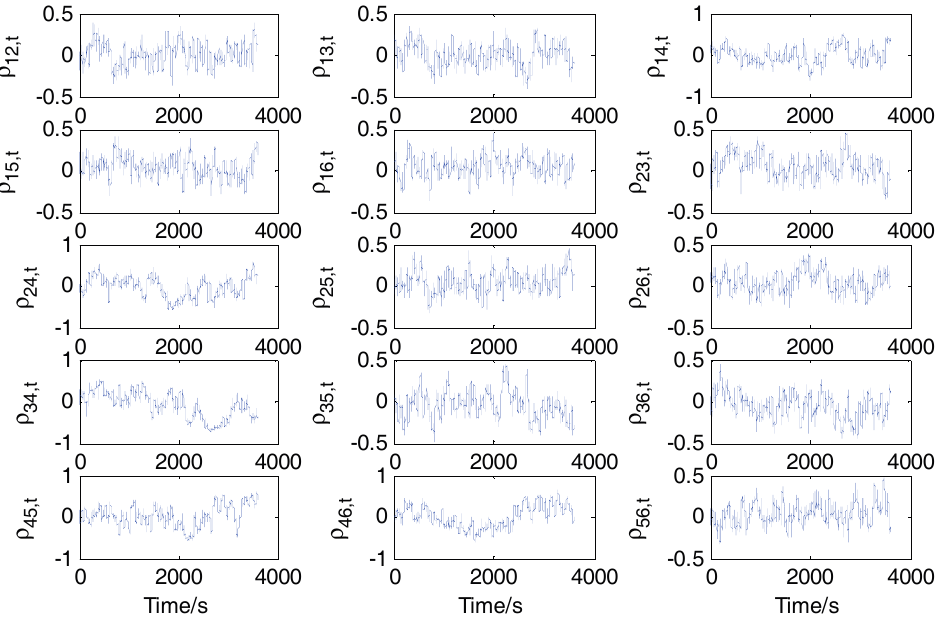
Figure 6. Curve of dynamic correlation coefficient.